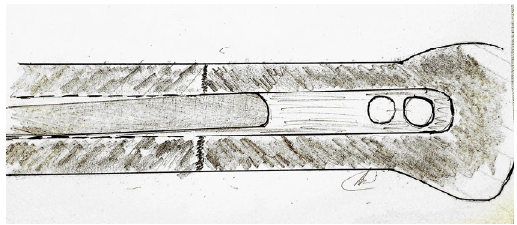
Figure 2. Small Kuntscher nail—for press fit.